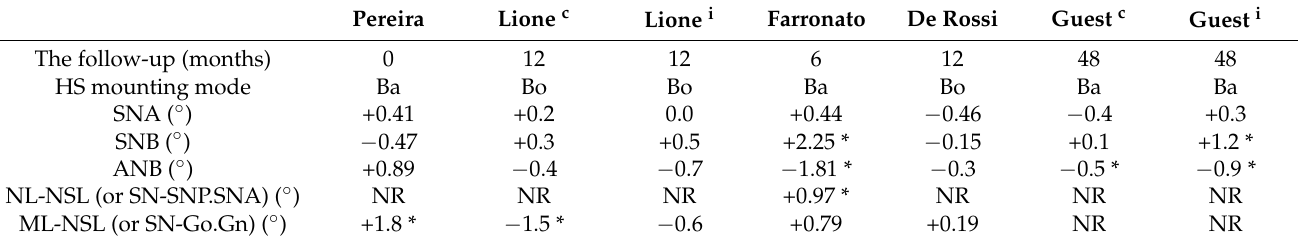
Table 6. Characteristics of post-RME changes in the sagittal and the vertical parameter values. Pereira Lione c Lione i Farronato De Rossi Guest c Guest